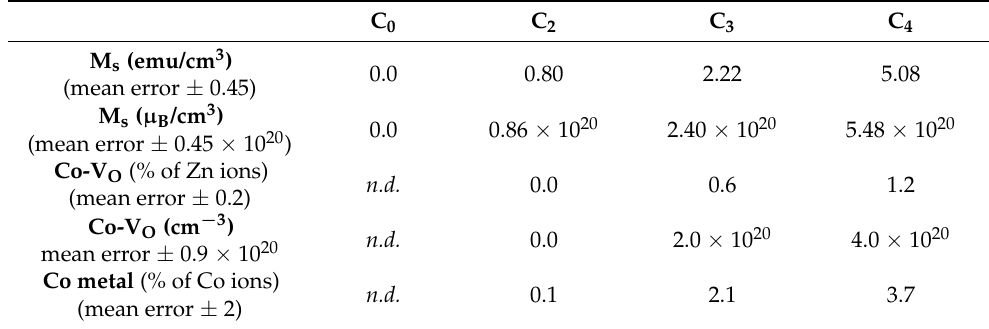
Figure 5. Values of the carrier concentration (n- as measured; n corr - without the Co metal contribution) as a function of Co concentration (percent of Zn atoms) for the C0, C2, C3, and C4 films. Reproduced with permission from [24]. Copyright 2015 Royal Society of Chemistry. Table 1. Experimental values of some magnetic, structural and electrical parameters for the C0, C2, C3, and C4 films. Values of the magnetization M s and estimates of the Co metal and Co–V O complex concentrations for the C2 and C4 films are taken from [73]. Reproduced with permission from [24]. Copyright 2015 American Chemical Society.